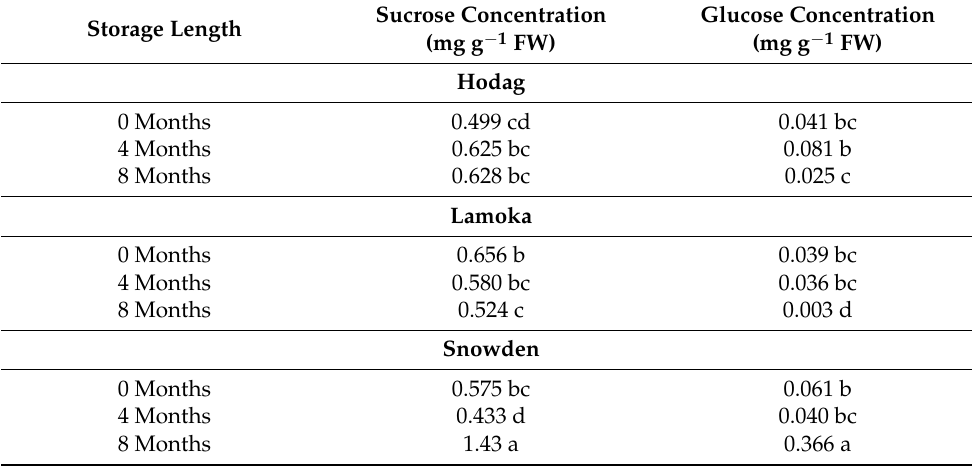
Table 8. Sucrose and glucose concentrations in 2018 significantly affected by the interaction between variety and storage length. Within each sugar type, numbers followed by different letters are significantly different at α =